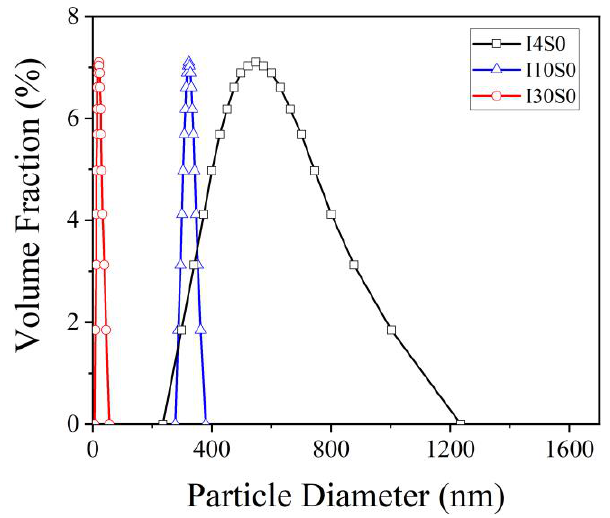
Figure 16. The particle size distribution of suspensions recycled from tap water electrolyte.